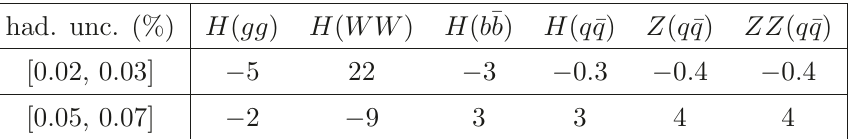
Table 1 . Estimated hadronization uncertainties of normalized distributions of thrust for two rep- resentative bins of τ